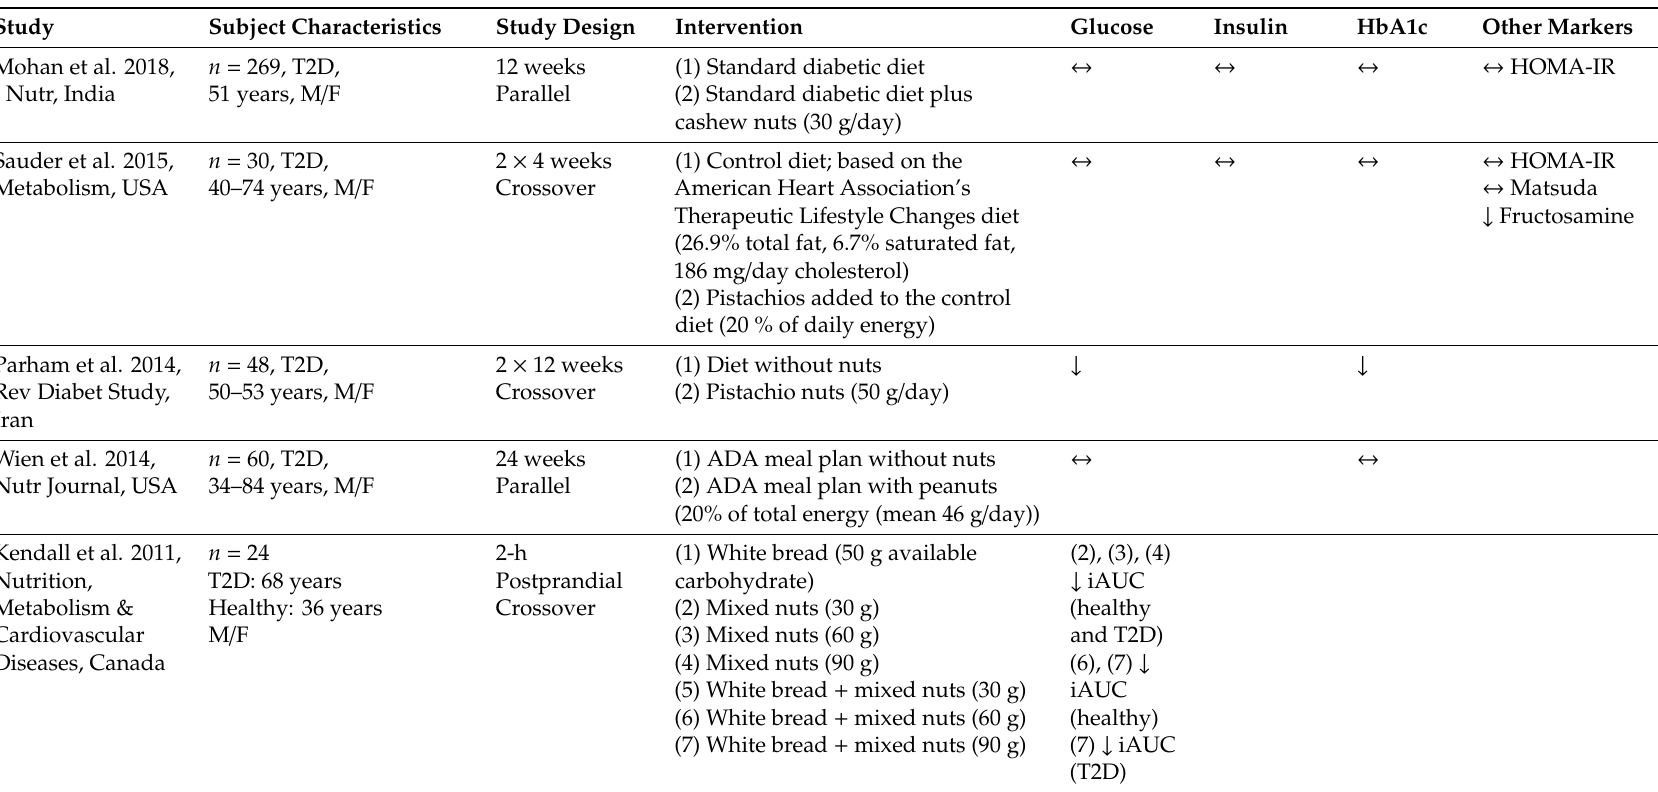
Table 3. E ff ects of nuts on glycemic regulation in type 2 diabetes in randomized controlled trials. Significant results are indicated by an up / down